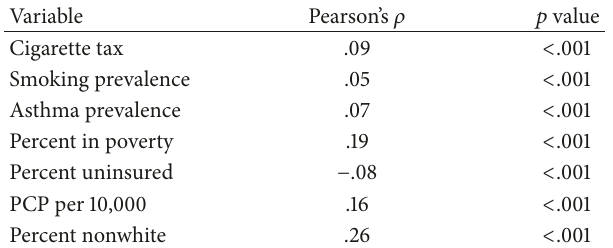
Table 2: Factors associated with asthma discharge rates per 10,000. Table 3: Effects of changes in county smoke-free laws on hospital discharges for asthma among working age